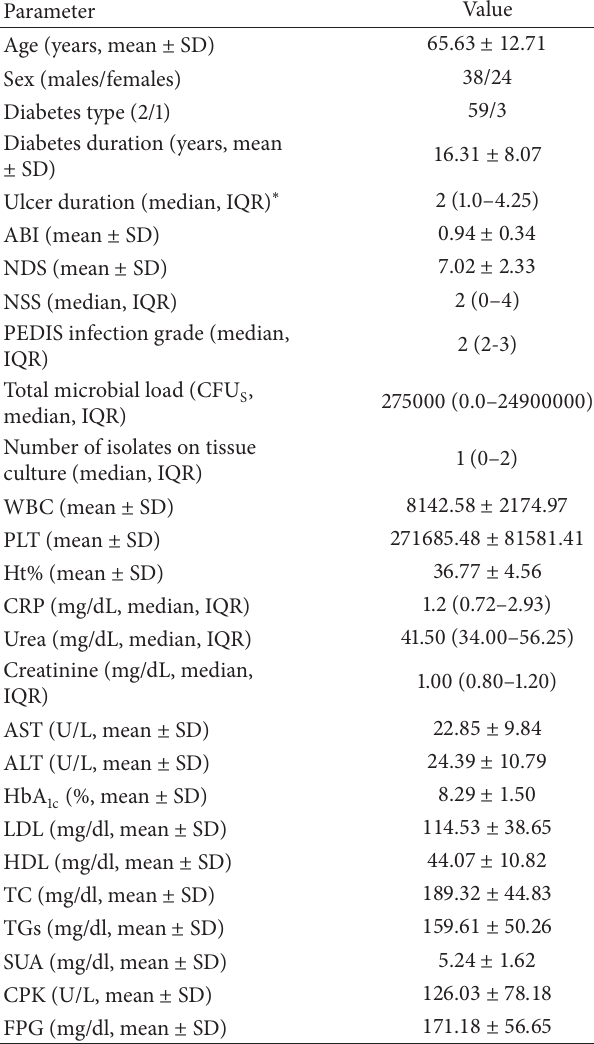
Table 1: Patient